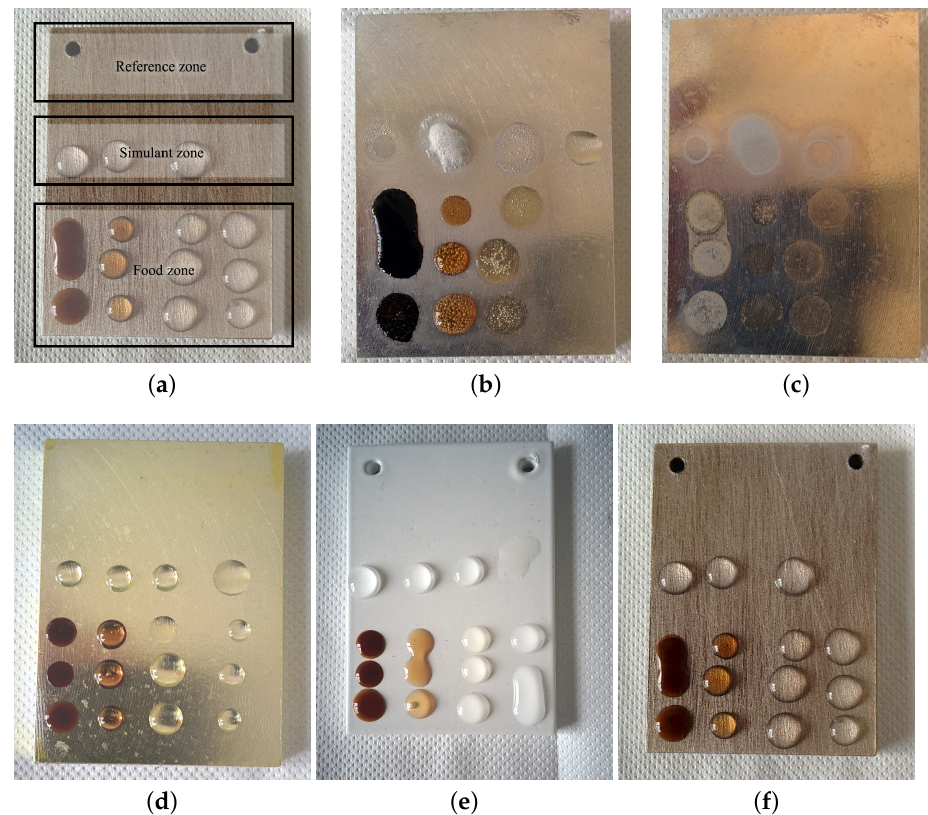
Figure 5. Drop test on uncoated AM60 alloy (top) and ( d ) GSF lacquer, ( e ) white and ( f ) transparent PA11 coatings (bottom); ( a ) shows how samples were divided for the different analyses: In simulant zone the four drops are A, B, C, D solutions; In food zone, from left to right coffee, Coca Cola ® , white sparkling wine and 10% acetic acid. ( b , c ) show the bare magnesium sample during the test and after rinsing. ( d – f ) show GSF transparent lacquer 12µm, white PA11 and transparent PA11 transparent